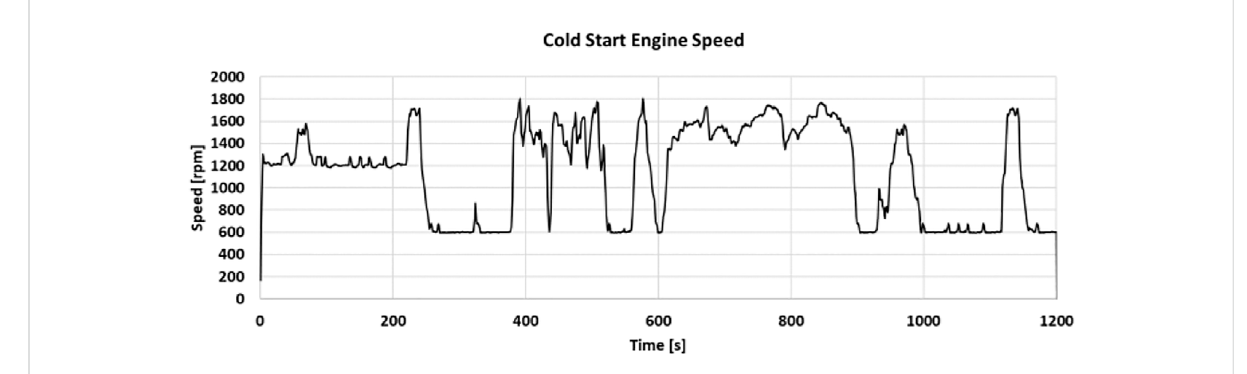
FIGURE 5 Cold Start HD-FTP engine speed measurement.